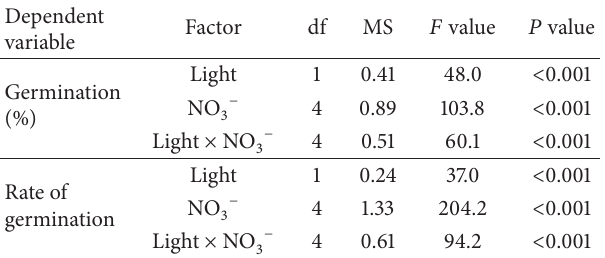
Table 2: Two-way analysis of variance (ANOVA) showing the effect of particular factors (light and NO 3 − ) on final and rate of germination. Data were transformed (arcsine) to achieve